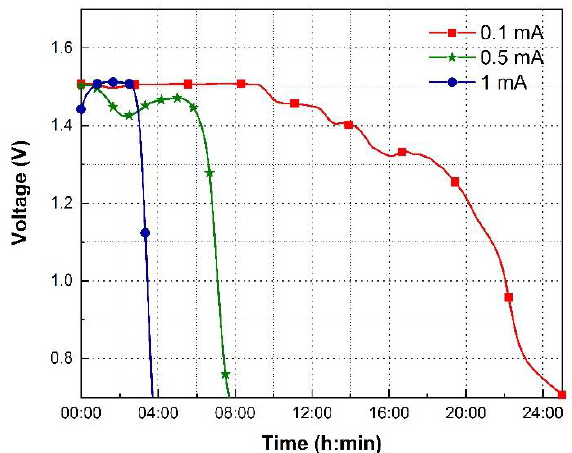
Figure 9. Discharge profiles of the flexible battery when discharged at 0.1 mA, 0.5 mA, and 1 mA without bending.